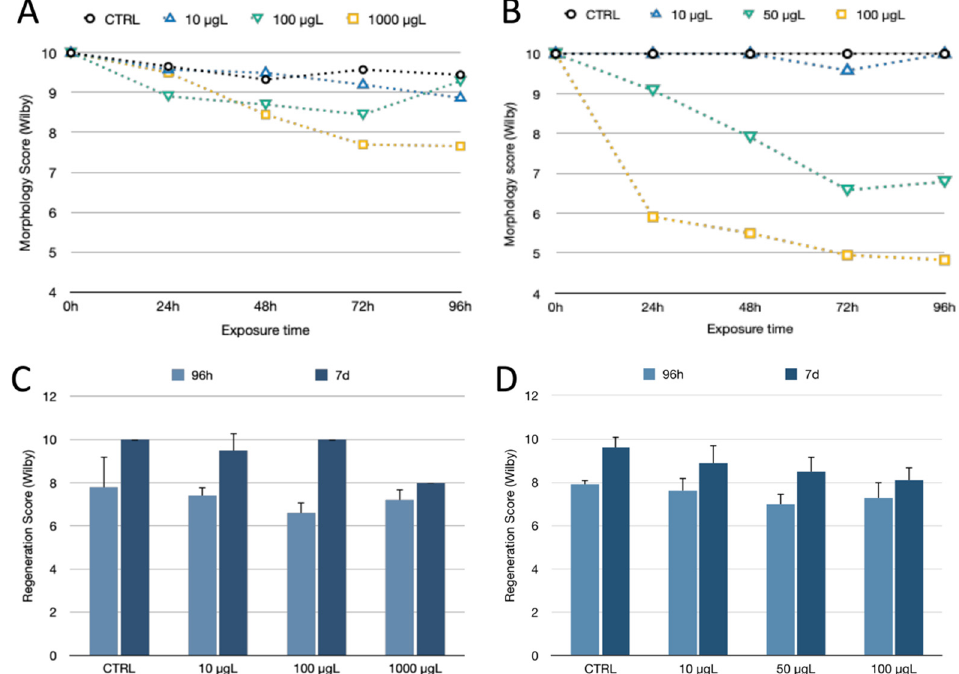
Figure 2. Morphology and regeneration score according to Wilby for H. vulgaris exposed to AgNPcitLcys ( A , C ) and AgNO 3 ( B , D ) for 96 h (morphology) and 96 h and 7 days (morphology and regeneration) at 0 (CTRL), 10, 100, and 1000 μ g/L for AgNPcitLcys and 0 (CTRL), 10, 50, and 100 μ g/L for AgNO 3 . Each data point is the mean value obtained from 12 specimens with standard deviation.